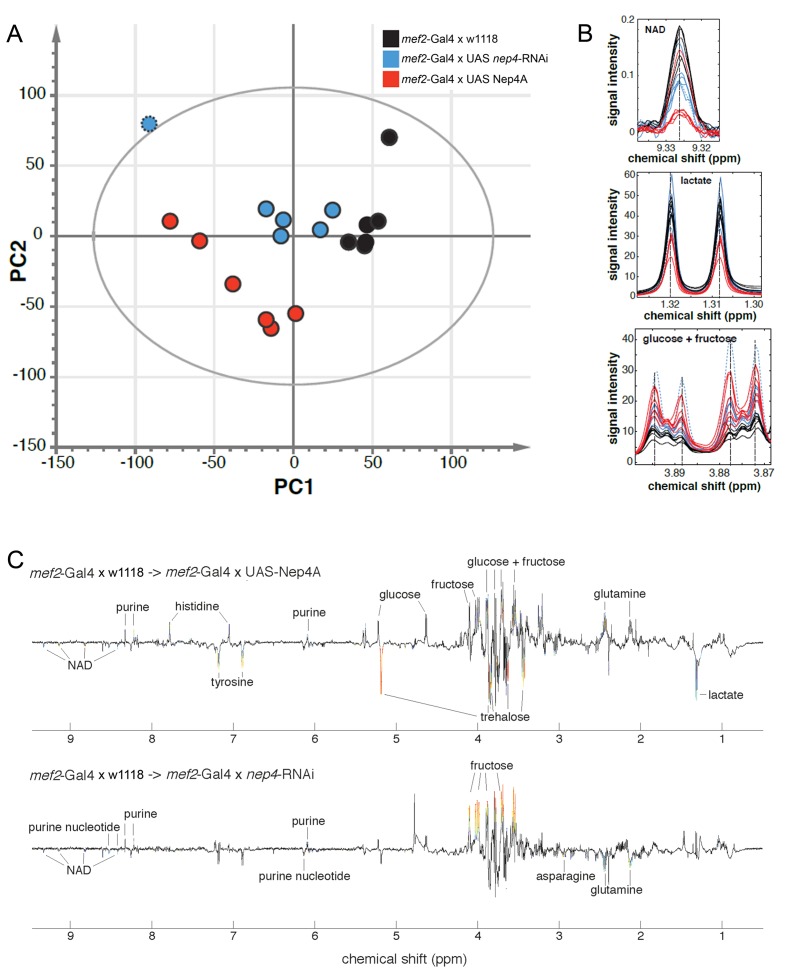
Muscle-specific modulation of nep4 expression affects the metabolite composition in transgenic third instar larvae.(A) Score plot based on genotype-specific NMR spectra. PCA score plot showing the scores of six biological replicates for each genotype. Principal component analysis (PCA) was applied to identify metabolite changes in response to muscle-specific Nep4A overexpression (mef2-Gal4 x UAS-Nep4A; red) or knockdown (mef2-Gal4 x UAS nep4-RNAi; blue), relative to control animals (mef2-Gal4 x w1118; black). The score plot reveals genotype-specific clustering and thus distinct metabolite compositions in corresponding animals. One nep4 knockdown sample was distinctly different from the other five. The outlier is marked by a dotted border and was excluded from OPLS-DA identification of significantly affected metabolites. (B) Examples of NMR signals from significantly affected metabolites. Evaluation of the dataset revealed that Nep4A overexpression significantly reduced NAD and lactate concentrations, while glucose and fructose levels were elevated in the same animals. The effects of nep4 knockdown were less severe; NAD was reduced, and fructose was slightly elevated, compared to levels in control animals. The coloring is the same as in A. The knockdown outlier is marked by a dotted line. (C) OPLS-DA loading plots summarizing the NMR spectral changes induced by nep4 overexpression and knockdown. Depicted is an overview of the metabolomic changes induced by modifying the expression of nep4. Positive and negative signals represent increases and decreases in metabolite concentrations, respectively. Significant alterations are color-coded from blue to red. Red represents the highest correlation between metabolite and genotype.DOI:
http://dx.doi.org/10.7554/eLife.19430.00610.7554/eLife.19430.007Figure 2—source data 1.Chemical shifts and detected changes of significantly affected metabolites.Significant changes are based on correlations with predictive scores from cross validated OPLS-DA models (Q2 = 0.95 and 0.74, respectively). A cutoff value for R2 corresponding to p<0.05 with Bonferroni correction for an assumed number of 100 metabolites was used.